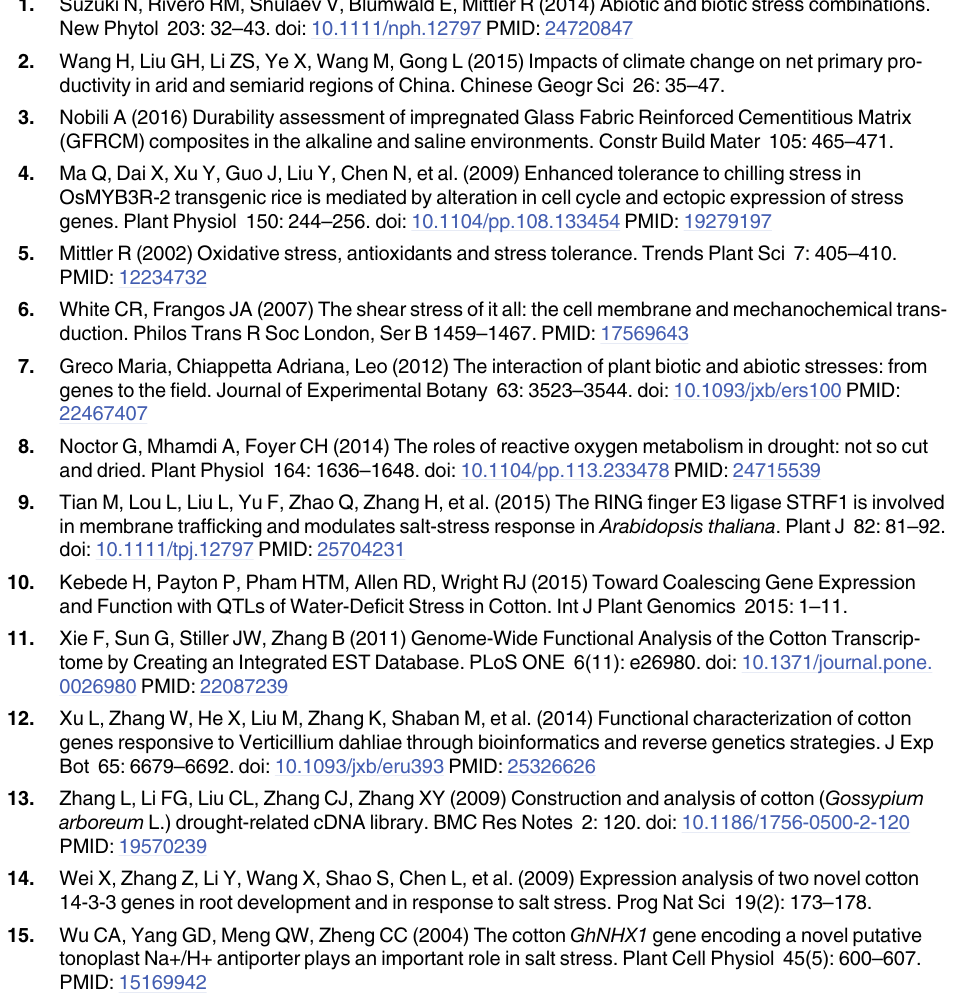
S11 Table. The main protein kinase families in stress-related genes. S12 Table. The distribution of hormone responsive genes. S13 Table. The distribution of active oxygen scavenging enzymes. S14 Table. Gene-specific primers used for